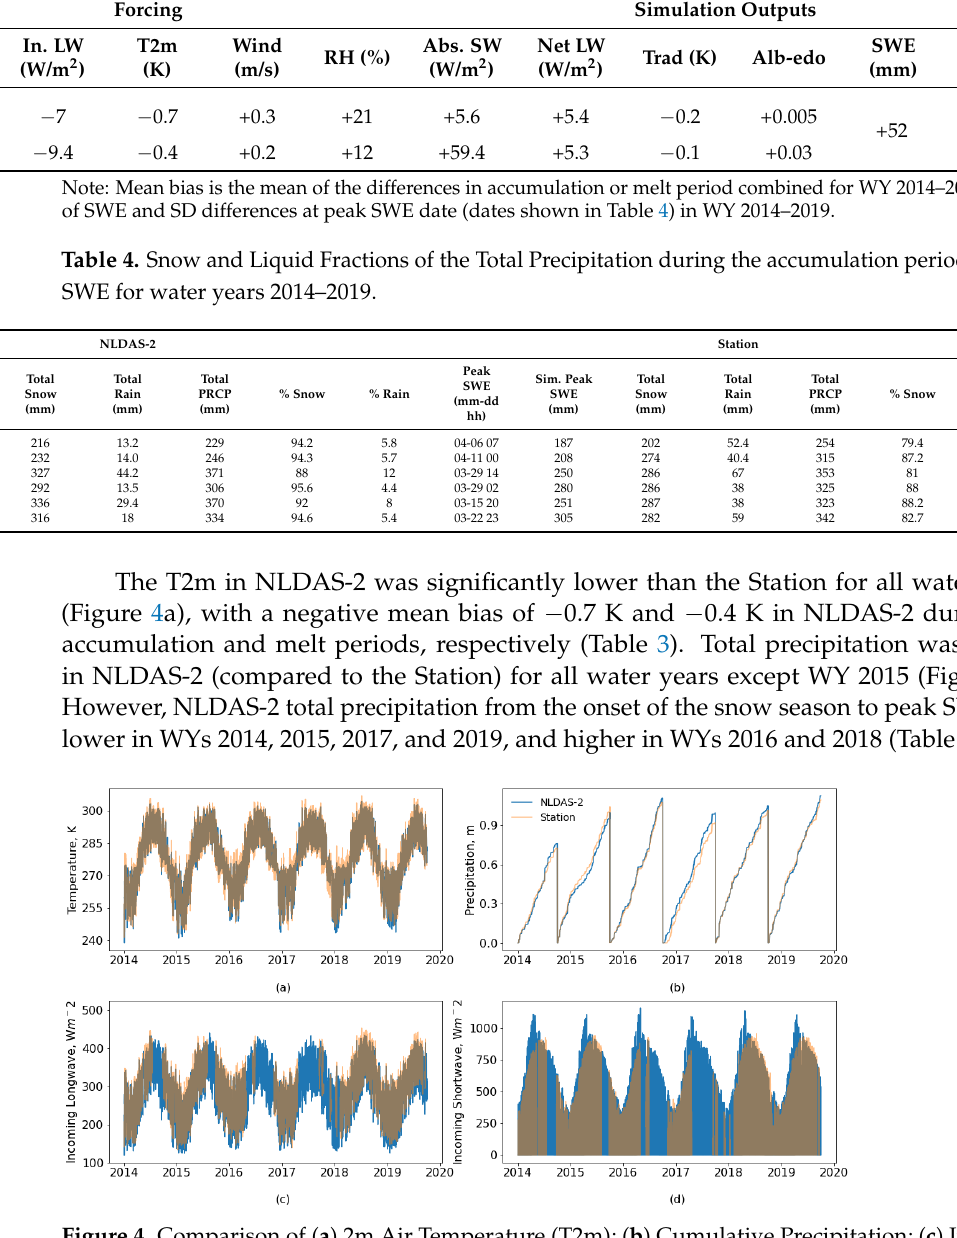
Figure 4. Comparison of ( a ) 2m Air Temperature (T2m); ( b ) Cumulative Precipitation; ( c ) Incoming Longwave Radiation; ( d ) Incoming Shortwave Radiation, forcing from NLDAS-2 versus those ob- served at the Station from WY2014 – WY2019 (Note: days where Station values were missing are left blank; NLDAS-2 forcing was used for the Station-Noah-MP simulation for the days that the Station forcing was missing).